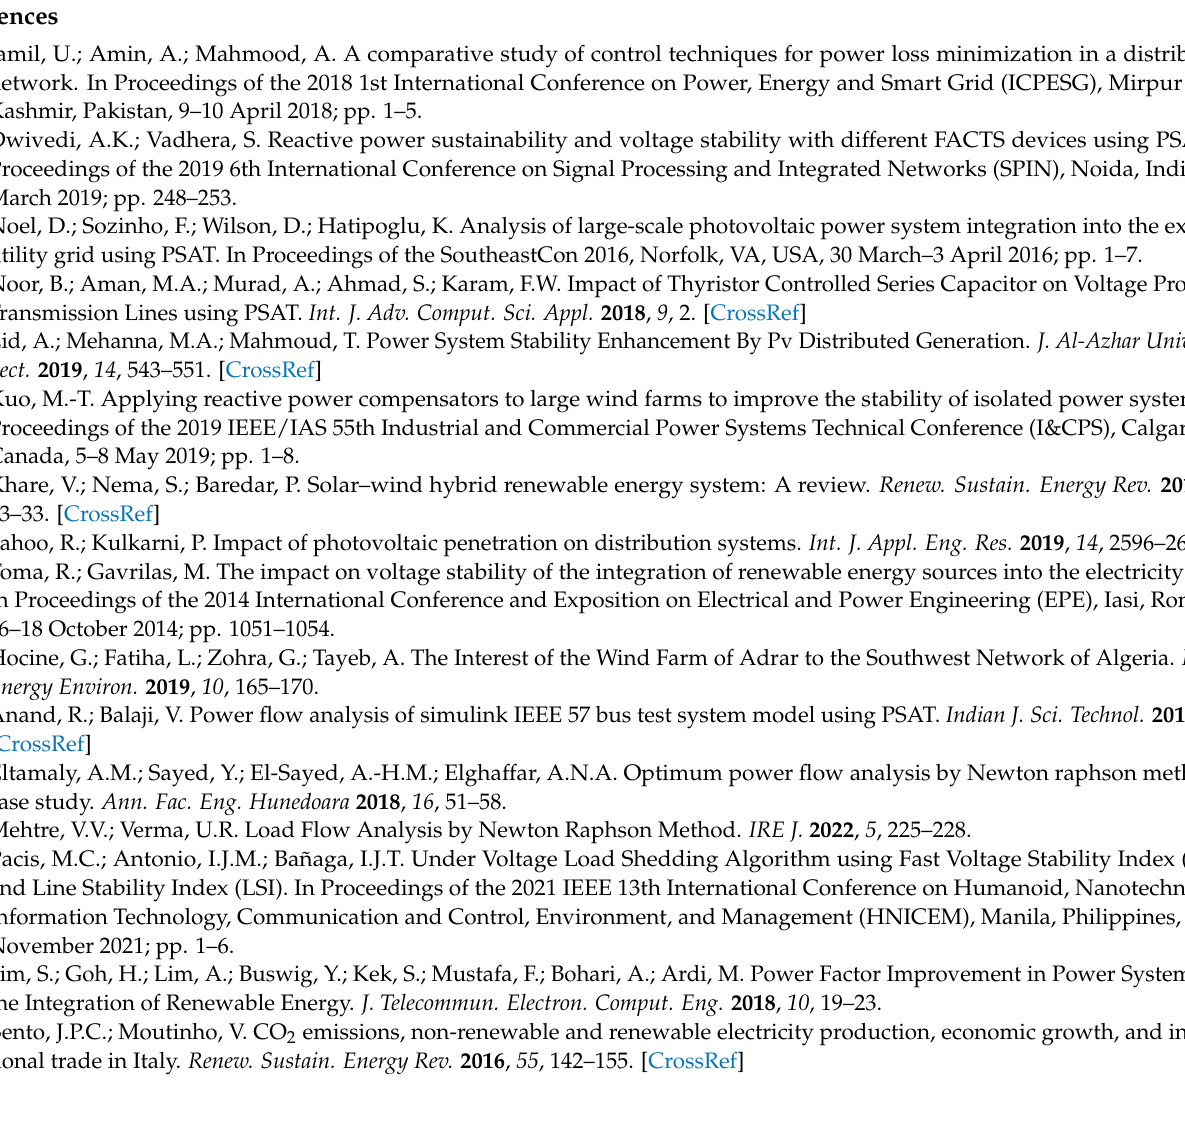
Figure A2. Comparison of SCIG output voltage with different wind speeds.